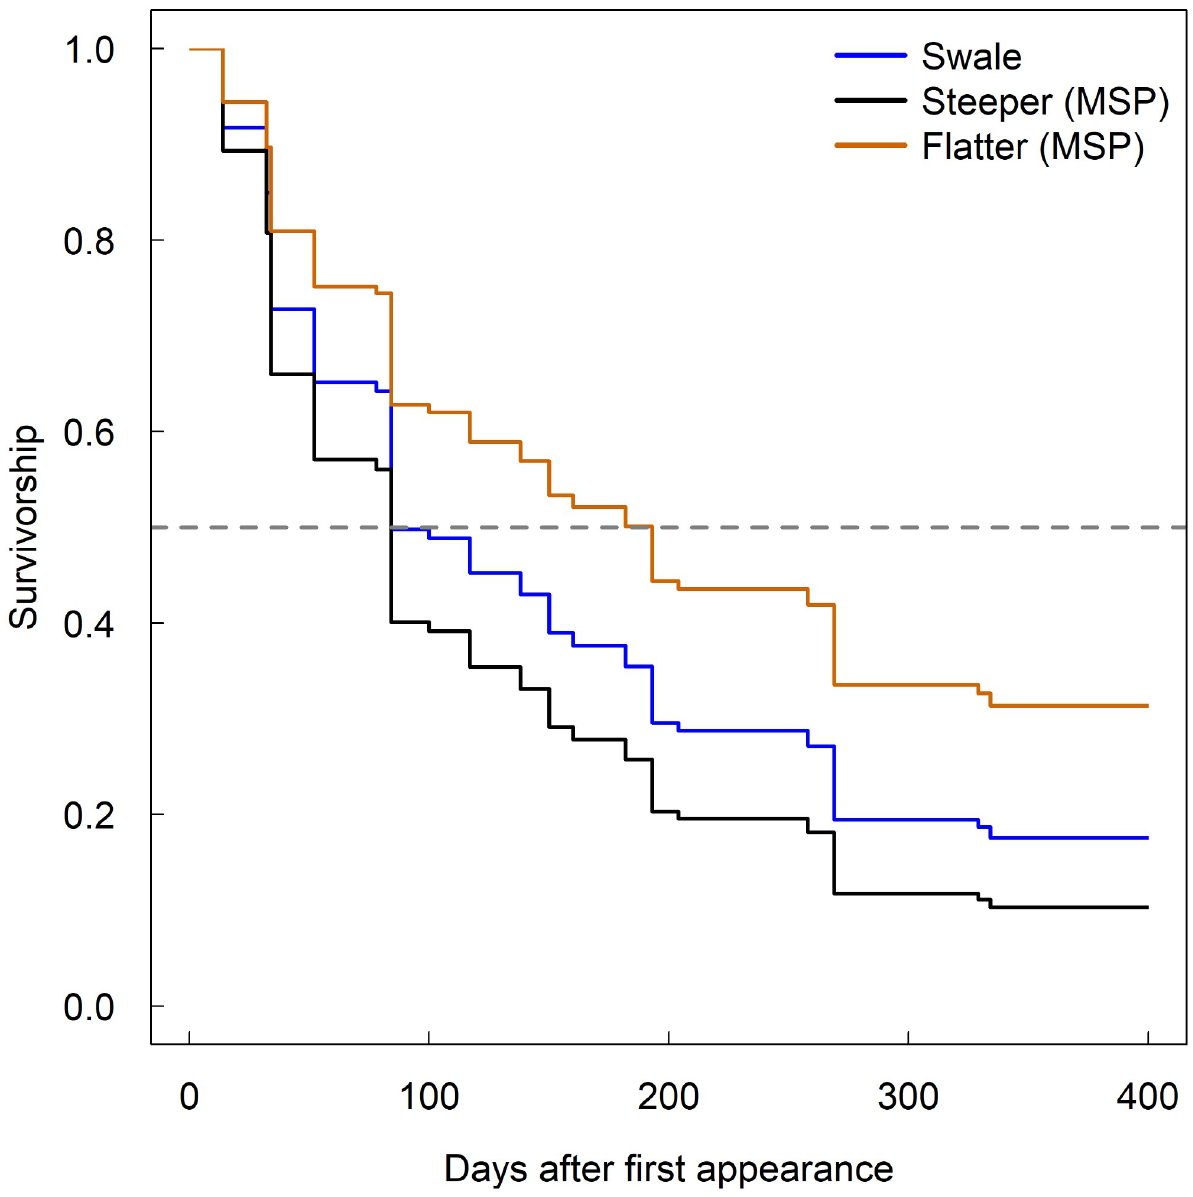
Fig 4. Influence of soil series on root survivorship in midslope locations. Survivorship curves of first-order roots in the top 10 cm of soil born in the spring of 2018 across soils on the north slope with different slope steepness, specifically: Steep Weikert (Steeper (MSP)), flatter Weikert (Flatter (MSP)), and Rushtown